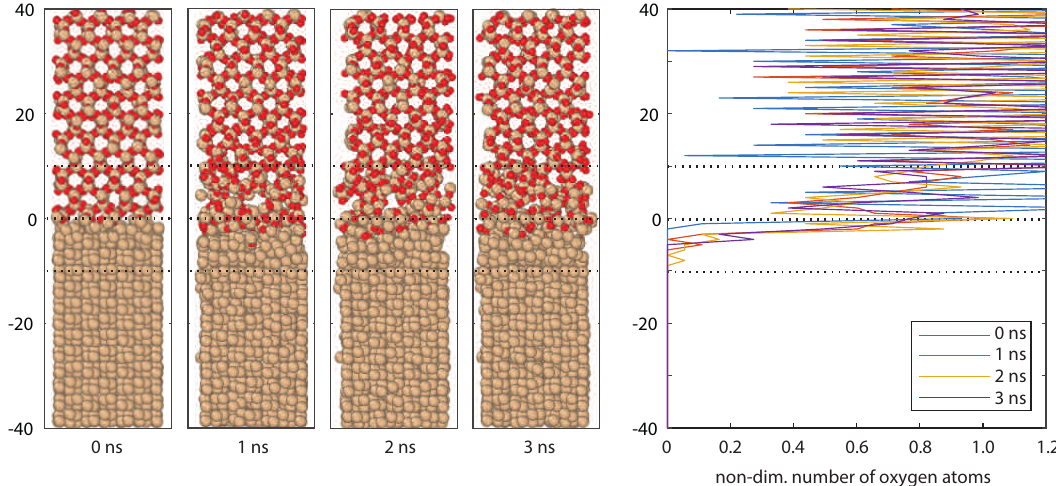
Figure A2. Snapshots of the Si/SiO 2